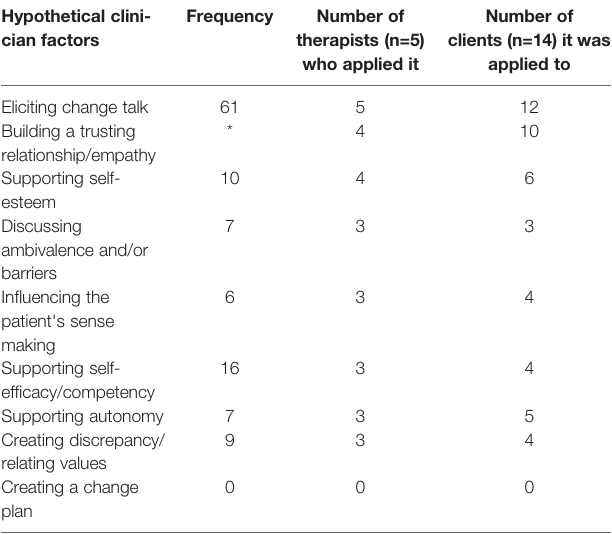
TABLE 4 | Application of clinician factors.